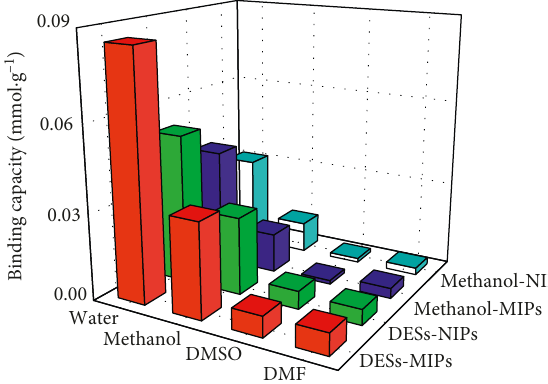
Figure 3: Binding capacities of DESs-MIPs, DESs-NIPs, methanol- MIPs, and methanol-NIPs in water, methanol, dimethyl sulfoxide (DMSO), and dimethyl formamide (DMF). 20.0mg of dried particles was placed in a 5mL Ep tube containing 3mL of levo- floxacin solution (1 μ